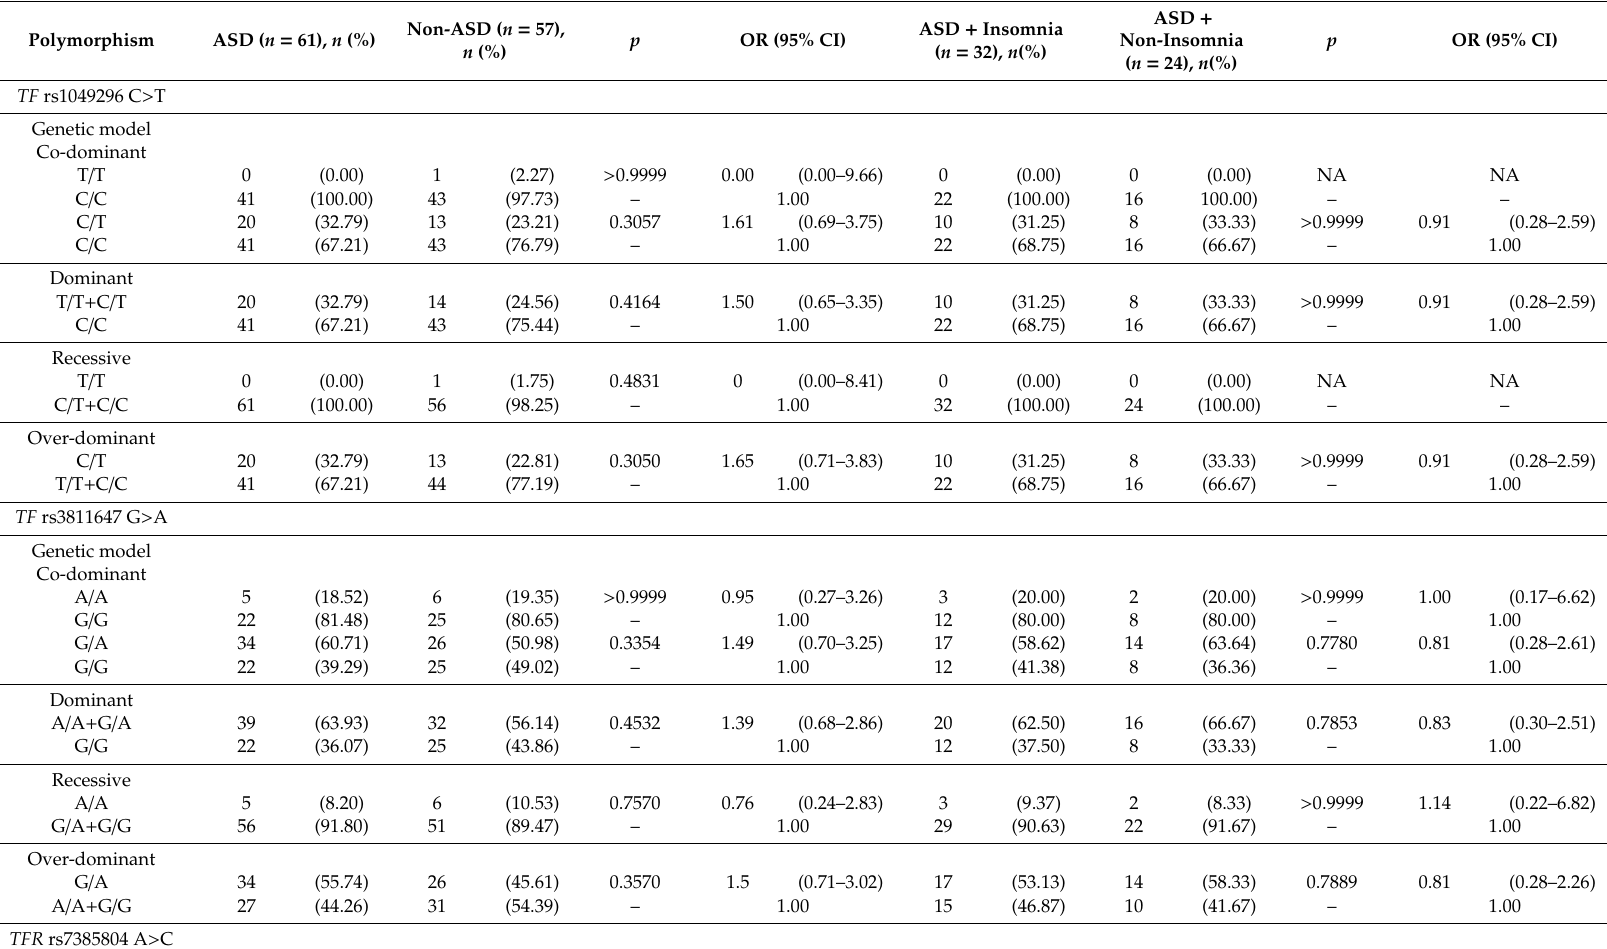
Table 2. Analysis of the TF, TFR and HAMP SNPs association with ASD and insomnia (AIS ≥ 6) using genetic inheritance models in individuals with ASD and insomnia (AIS ≥